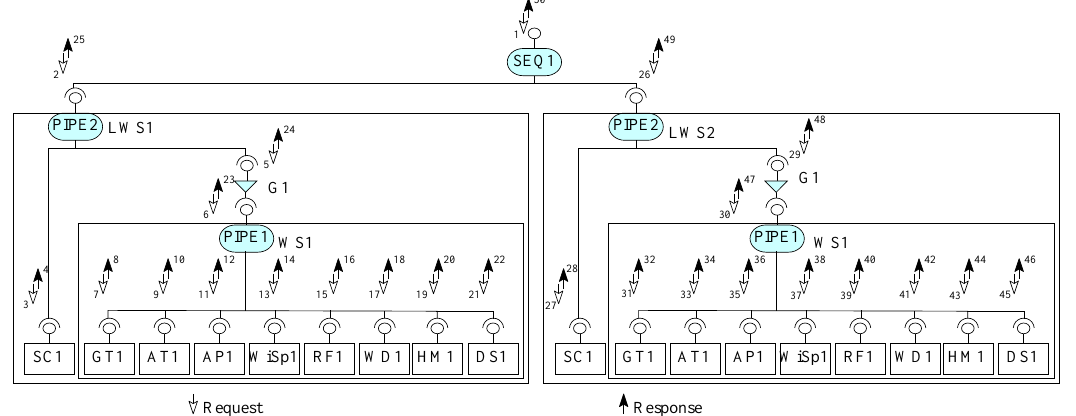
Figure 29. Two linked weather stations (LWS) in the Weather Information